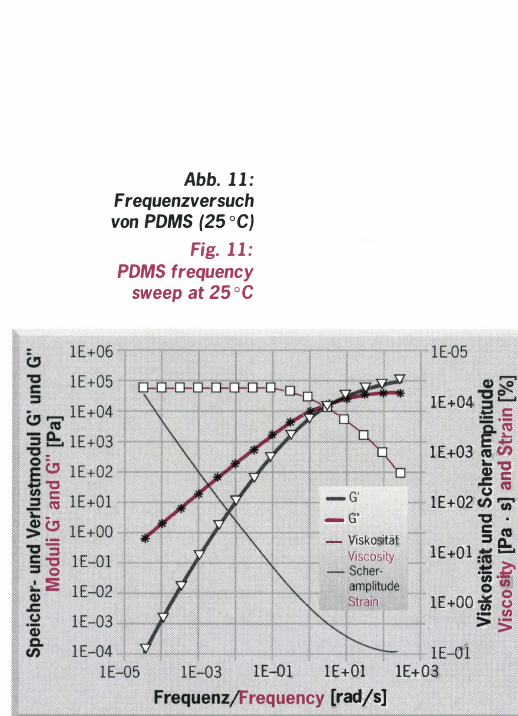
Frequency sweeps with strain controlled rheometers often require the operator to increase the applied strain as the frequency decreases in order to maintain the measured torque above the transducer limit. Other possibilities are to change the sample geometry or the transducer. However, both methods require the opera­ tor to interrupt the frequency sweep. On the other hand, stress controlled rheometers allow uninterrupted frequency sweeps down to very low frequencies due to a constant torque input and very large measurable deformations as illustrated in Fig. 1 1